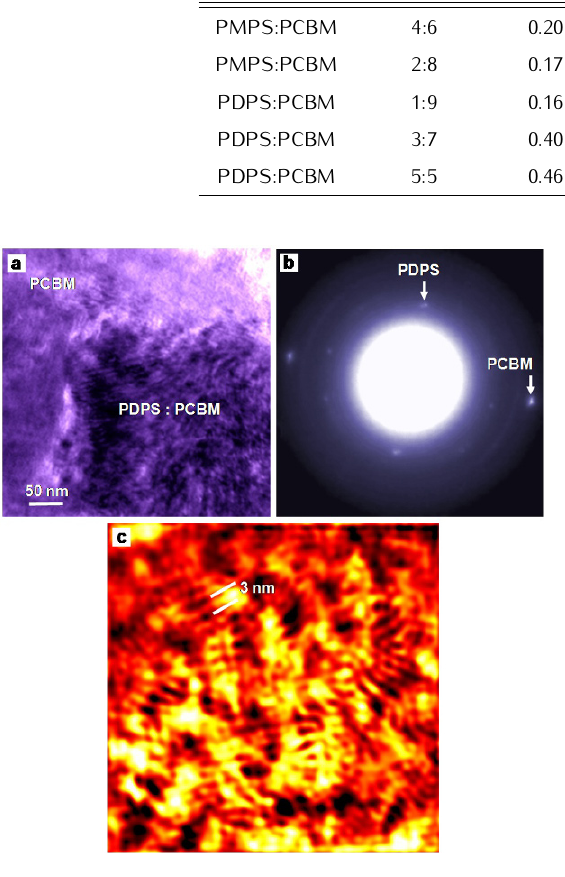
HOMO/LUMO of PDPS/PCBM is higher compared to